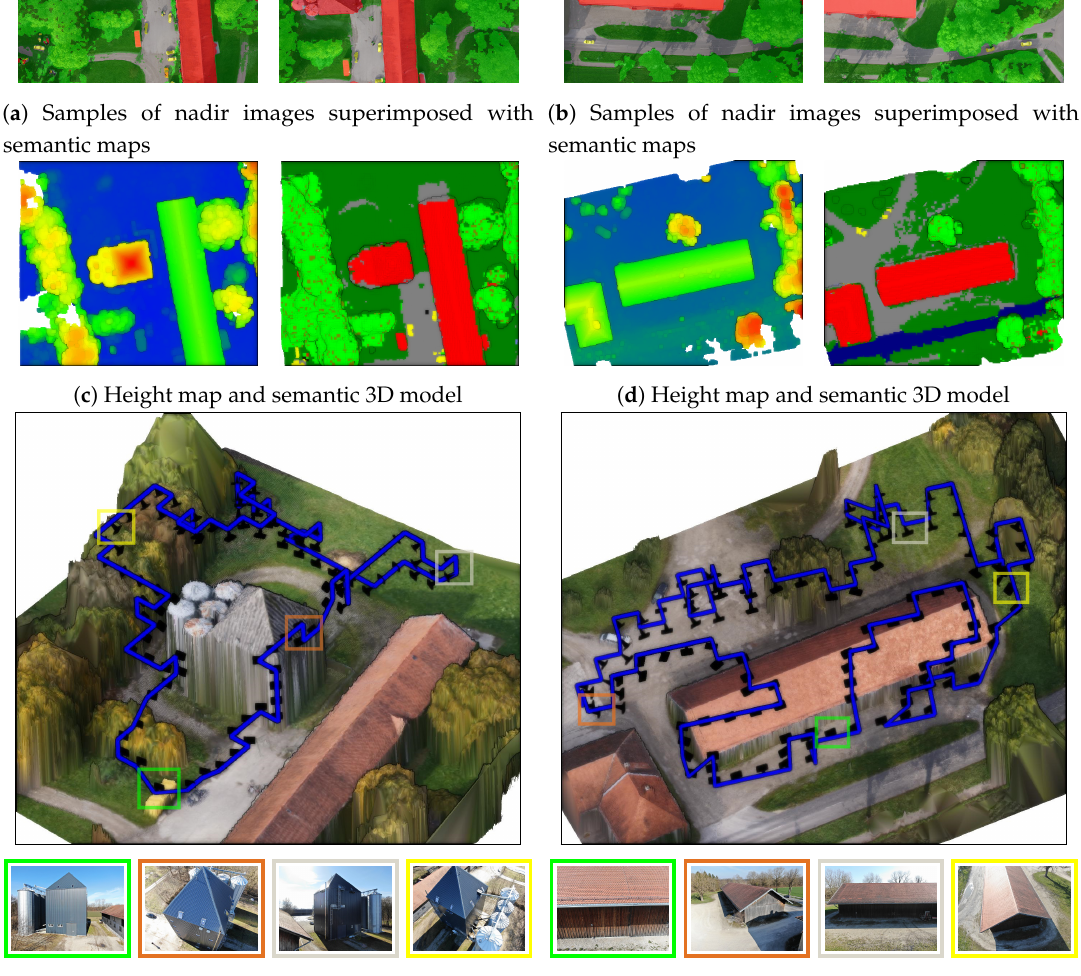
Figure 12. Real world experiments for the silo scene ( left ) and farm scene ( right ). A set of segmented nadir images ( a , b ) is used to generate a semantically enriched 3D proxy model of the entire scene ( c , d ). The final trajectories (blue lines) and discrete image acquisition viewpoints (black cameras) are visualized in ( e , f ) including sample images for the highlighted viewpoints. The restricted areas include adjacent buildings for the silo scene and adjacent buildings, as well as trunk roads for the farm